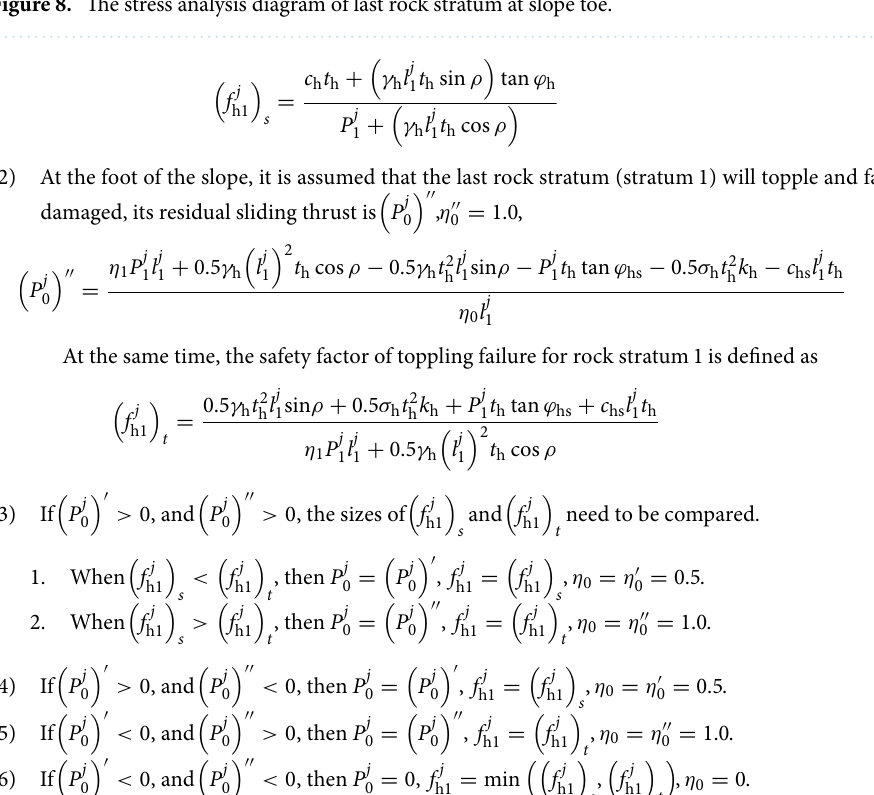
Figure 8. The stress analysis diagram of last rock stratum at slope